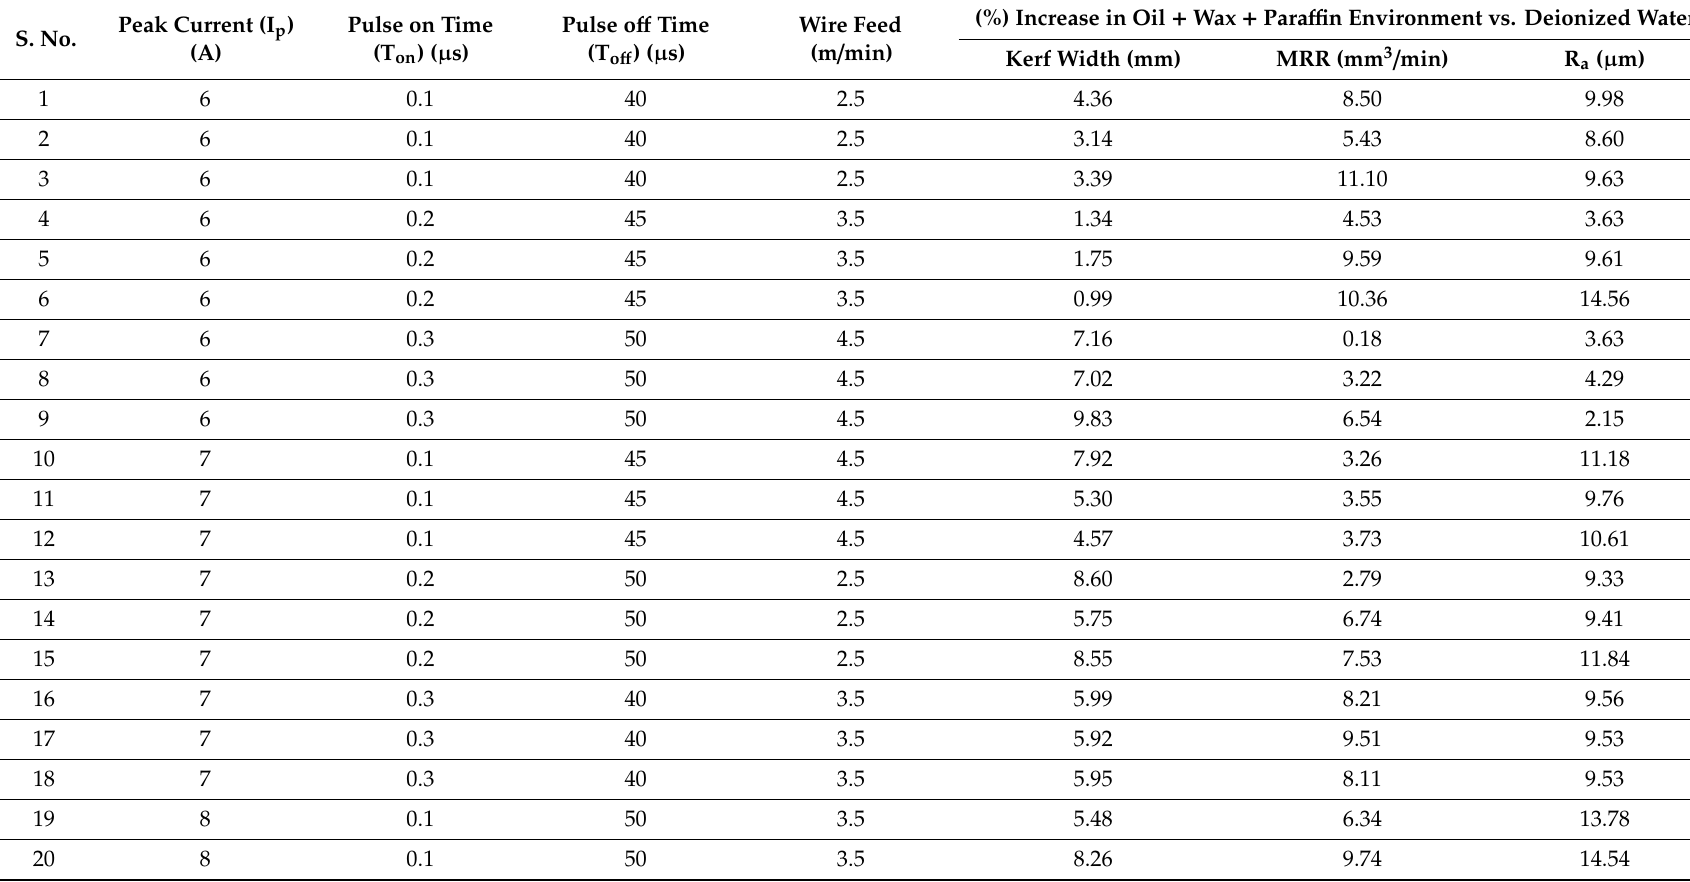
Table 11. Comparison between for wire electrical discharge cutting of the Al-SiC-TiC metal matrix composite in deionized water and oil + wax + para ffi n dielectric